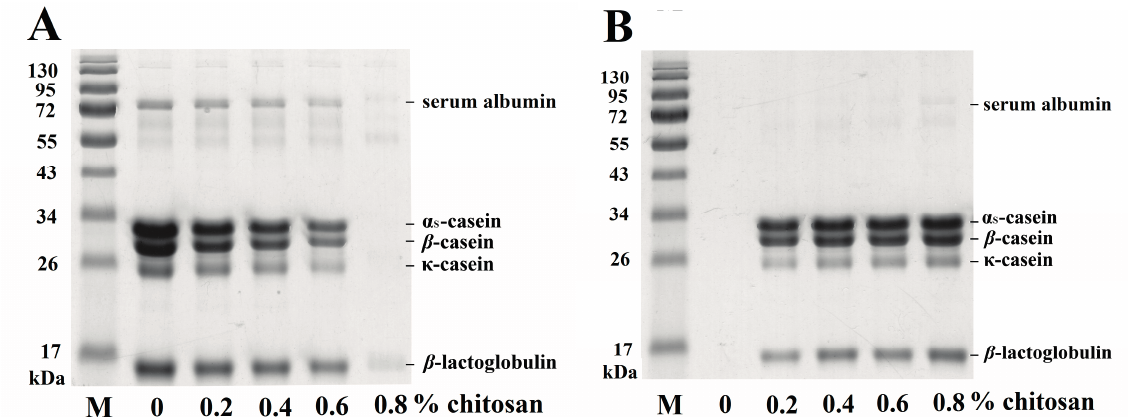
Figure 2. Changes in the SDS-PAGE profiles of milk samples treated with different concentrations of chitosan (0, 0.2%, 0.4%, 0.6% or 0.8%) incubated at 30 °C for 1 h. ( A ) milk supernatant fraction; ( B ) milk pellet fraction; M: protein